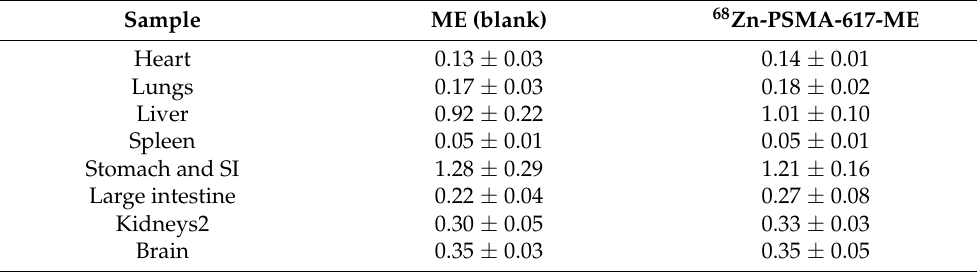
Table 2. Comparison of organ weights (g) following gross necropsy of BALB/c mice.